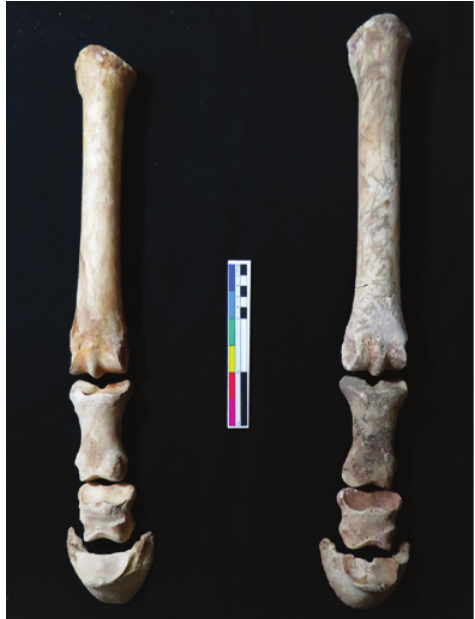
Figure 5 Articulated right metatarsals and phalanges of Ku. 209 (left) and Ku. 210 (right). (Image credit: Giulia Mazzetti)